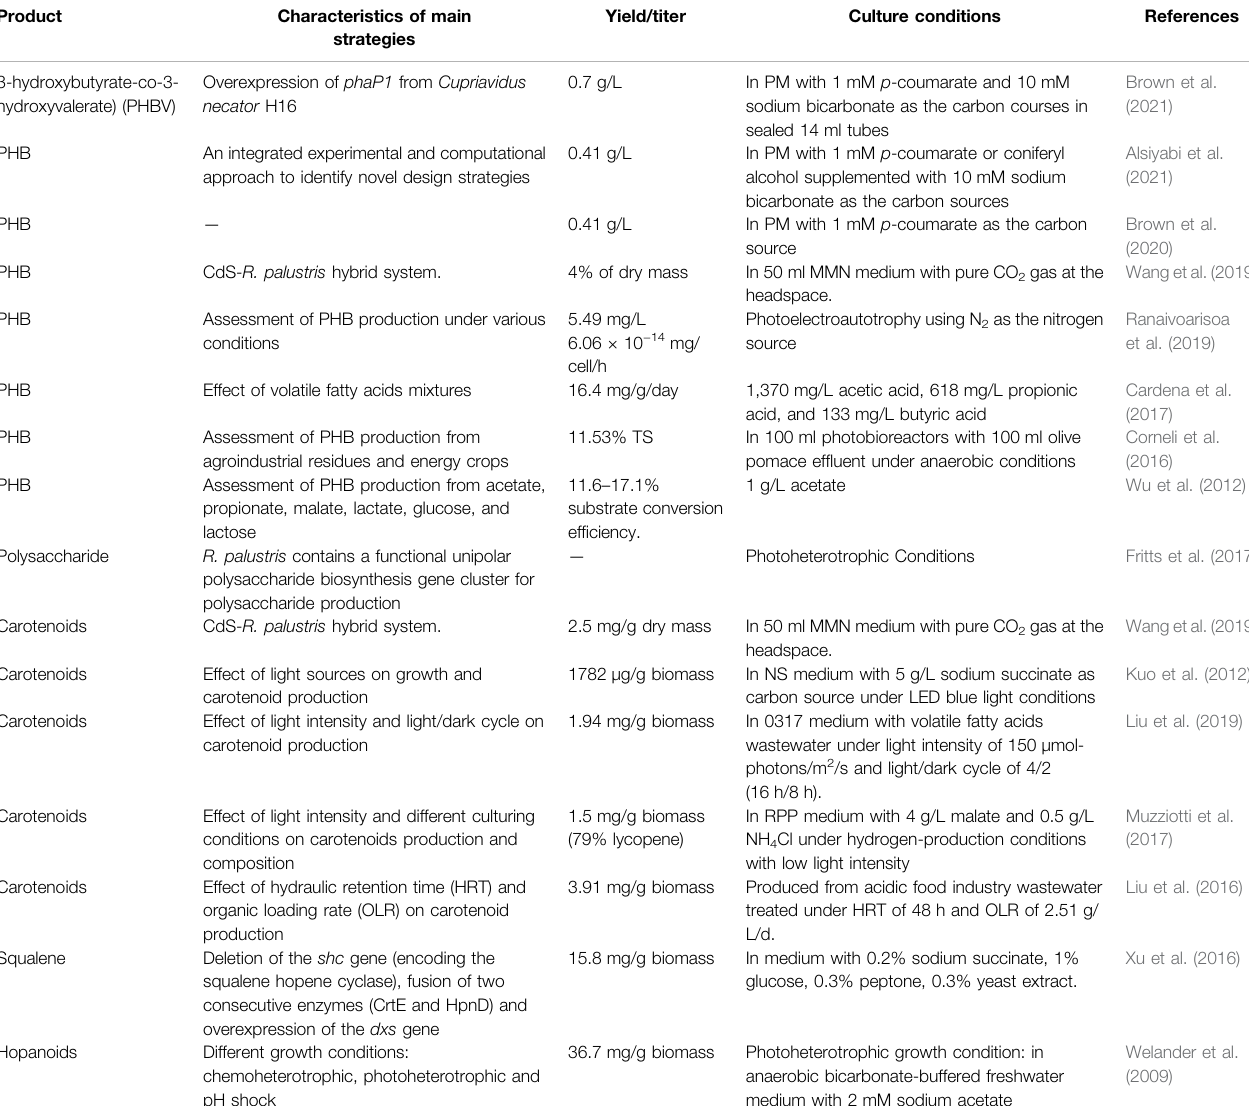
TABLE 2 | Summary of biopolymers and their building blocks production in R. palustris .